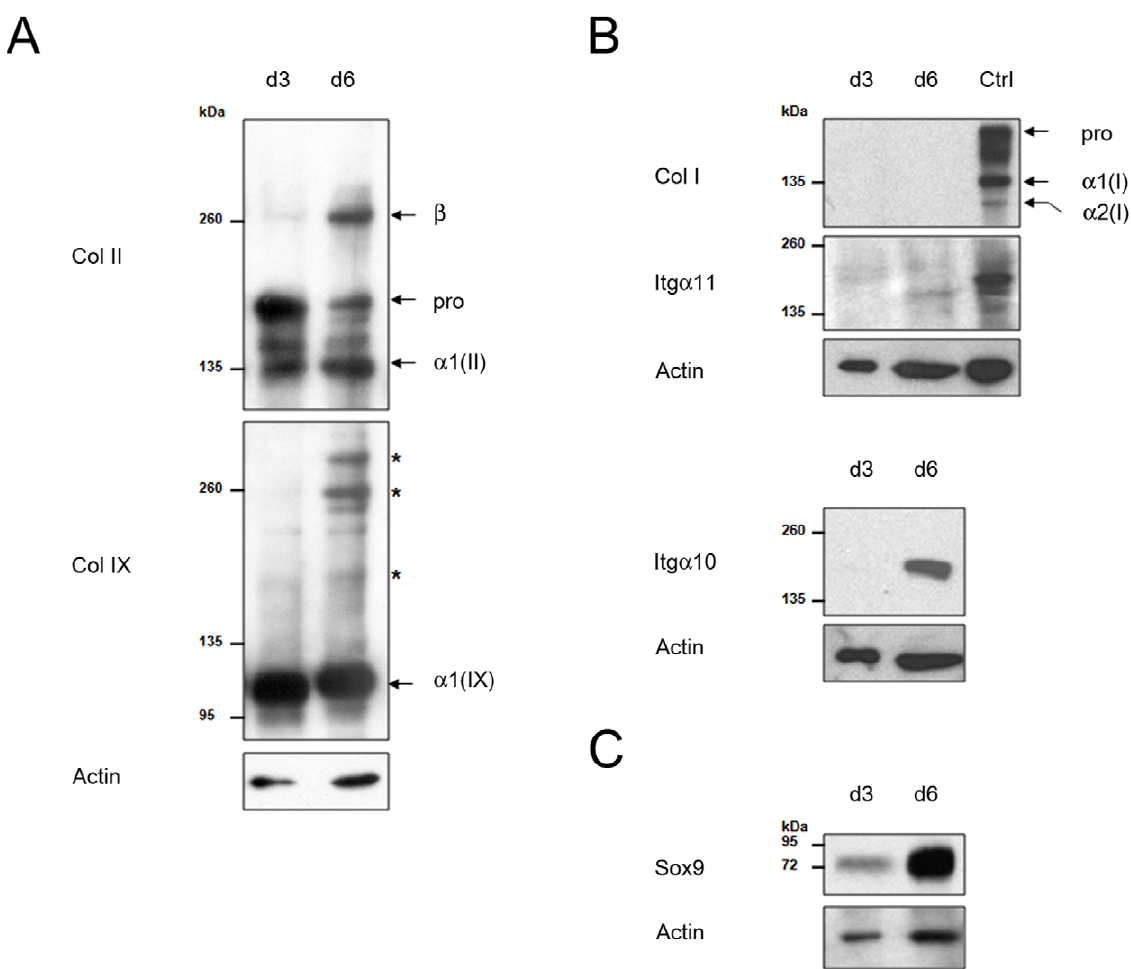
Figure 1. Chondrocytes embedded in agarose gel maintain a well-differentiated phenotype. Expression of extracellular matrix proteins, integrins and the Sox9 transcription factor were analysed on Western blots of chondrocytes cultured in 3D for 3 days (d3) or 6 days (d6). The presence or absence patterns of proteins at day 6 are representative of 3 independent experiments. A: Type II (Col II) and type IX (Col IX) collagens accumulate and become cross-linked by day 6. Procollagen II forms (pro) and mature collagen II chains [ a 1(II)] are present. Beta ( b ) indicates cross-linked a 1(II) dimers. Collagen IX chains [ a 1(IX)] are present. Asterisks (*) indicate cross-linked collagens. B: Type I collagen (Col I) and a 11 integrin (Itg a 11) are not or only faintly detected, whereas the chondrocyte-specific a 10 integrin (Itg a 10) is present at day 6. Passaged chondrocytes cultured in monolayer were used as positive controls (Ctrl) for Col I and a 11 integrin immunorevelations. Procollagen I (pro) and mature collagen I chains a 1(I) and a 2(I) are indicated. C: Sox9 chondrogenic transcription factor increases with the duration of